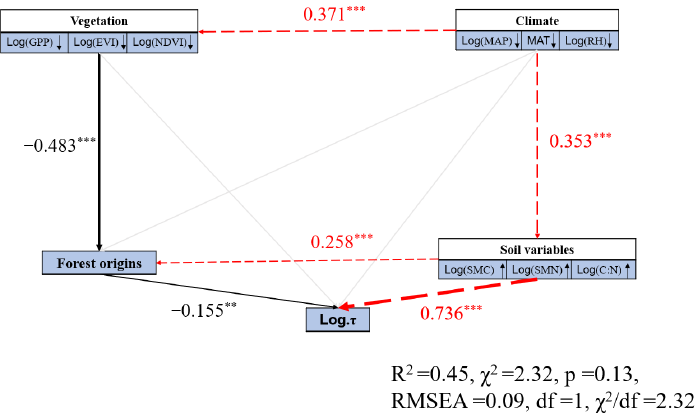
Figure A11. The main influencing factors of C turnover in the subsoil of ENF were obtained by the SEM model. The symbols “ ↑ ” and “ ↓ ” indicate a positive or negative correlation between environ- mental factors and subsoil τ . The goodness of fit statistics for the effect size model of the relationship are as follows: *** p < 0.001.